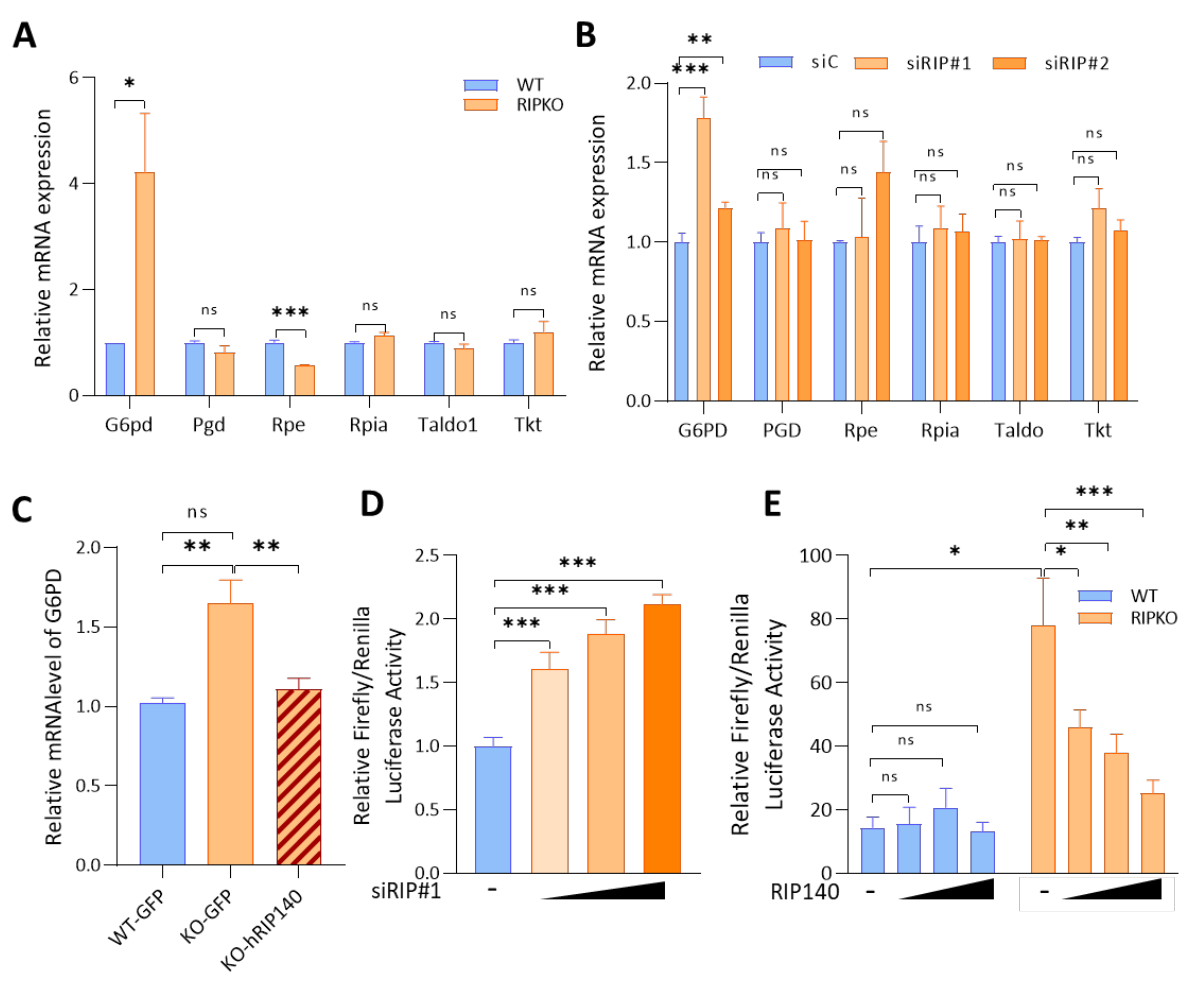
Figure 1. RIP140 inhibits G6PD gene expression at the transcriptional level. ( A , B ) mRNA expres- sion of the indicated genes was quantified by RT-qPCR in MEF WT or RIP140 knock-out (RIPKO) (values are normalized to WT samples) ( A ) and in MDA-MB-436 transfected with control siRNA (siC) or RIP140 siRNAs (siRIP#1; siRIP#2). Values are normalized to control siRNA samples ( B ). Name